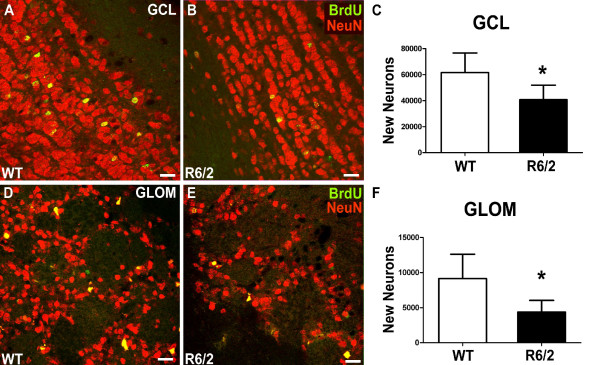
The generation of new neurons in the neurogenic regions of the olfactory bulb is impaired in R6/2 animals compared to controls. In the GCL the percentage of newly generated cells that differentiate into a neuronal phenotype is unchanged comparing WT and R6/2 animals, as determined by double-labeling for BrdU and NeuN (A, B). Calculation of absolute numbers of surviving new neurons in the GCL revealed significantly decreased neurogenesis in HD mice compared to controls (C). Analysis of differentiation in the GLOM demonstrated unchanged neuronal differentiation in this region as well. Calculation of the total number of newly generated neurons in the GLOM showed a reduction of more than 50% in R6/2 mice compared to WT controls (F). D and E show representative immunostainings for BrdU and NeuN in the GLOM. Error bars represent SD, * indicates p < 0.05. Scale bars represent 20 μm.